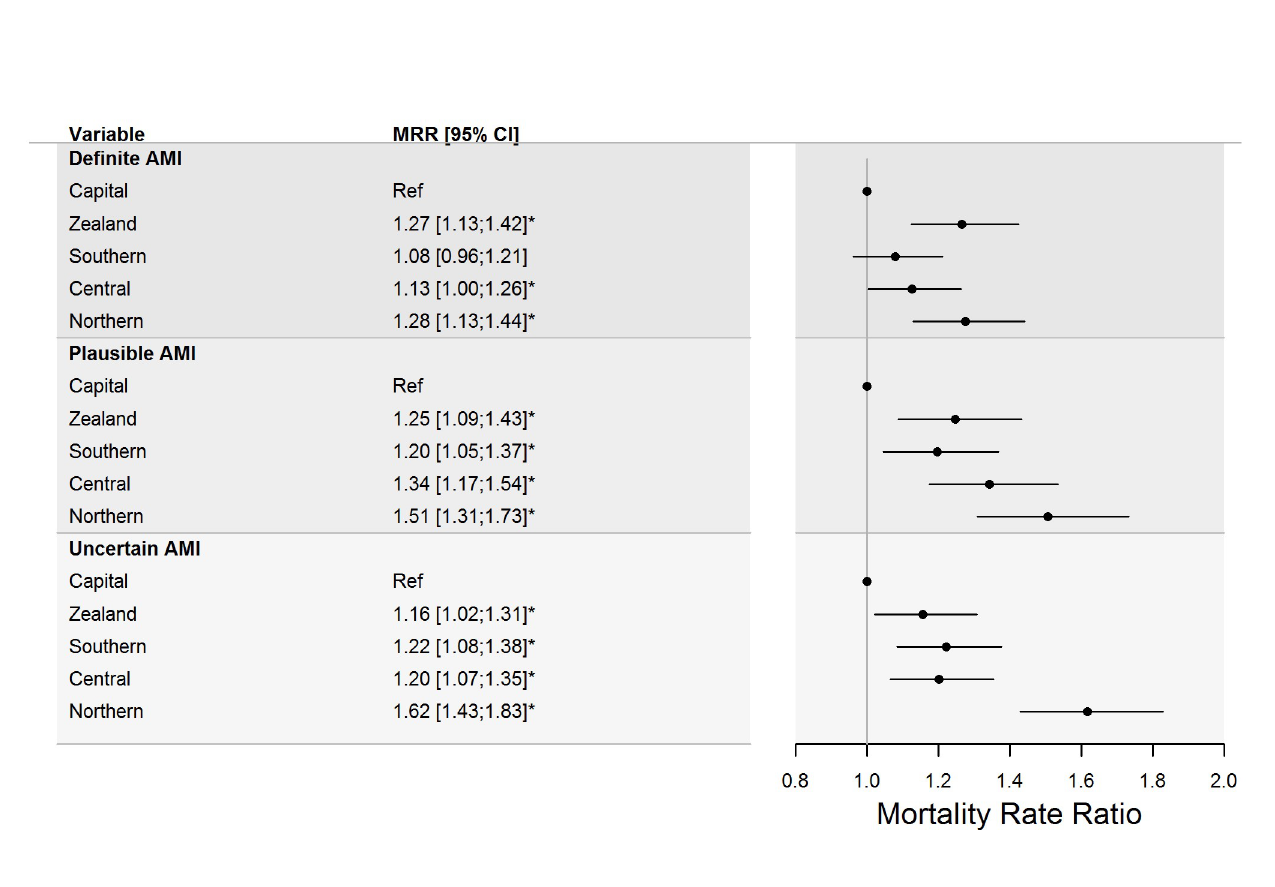
Fig 2. Standardised mortality rate ratios from acute myocardial infarction by diagnostic support and region. Forrest plot presenting standardised mortality rate ratios from acute myocardial infarction (AMI) by diagnostic support for fatal AMI with their 95% confidence intervals for each official Danish region ( N = 36,669), compared to the Capital Region of Denmark